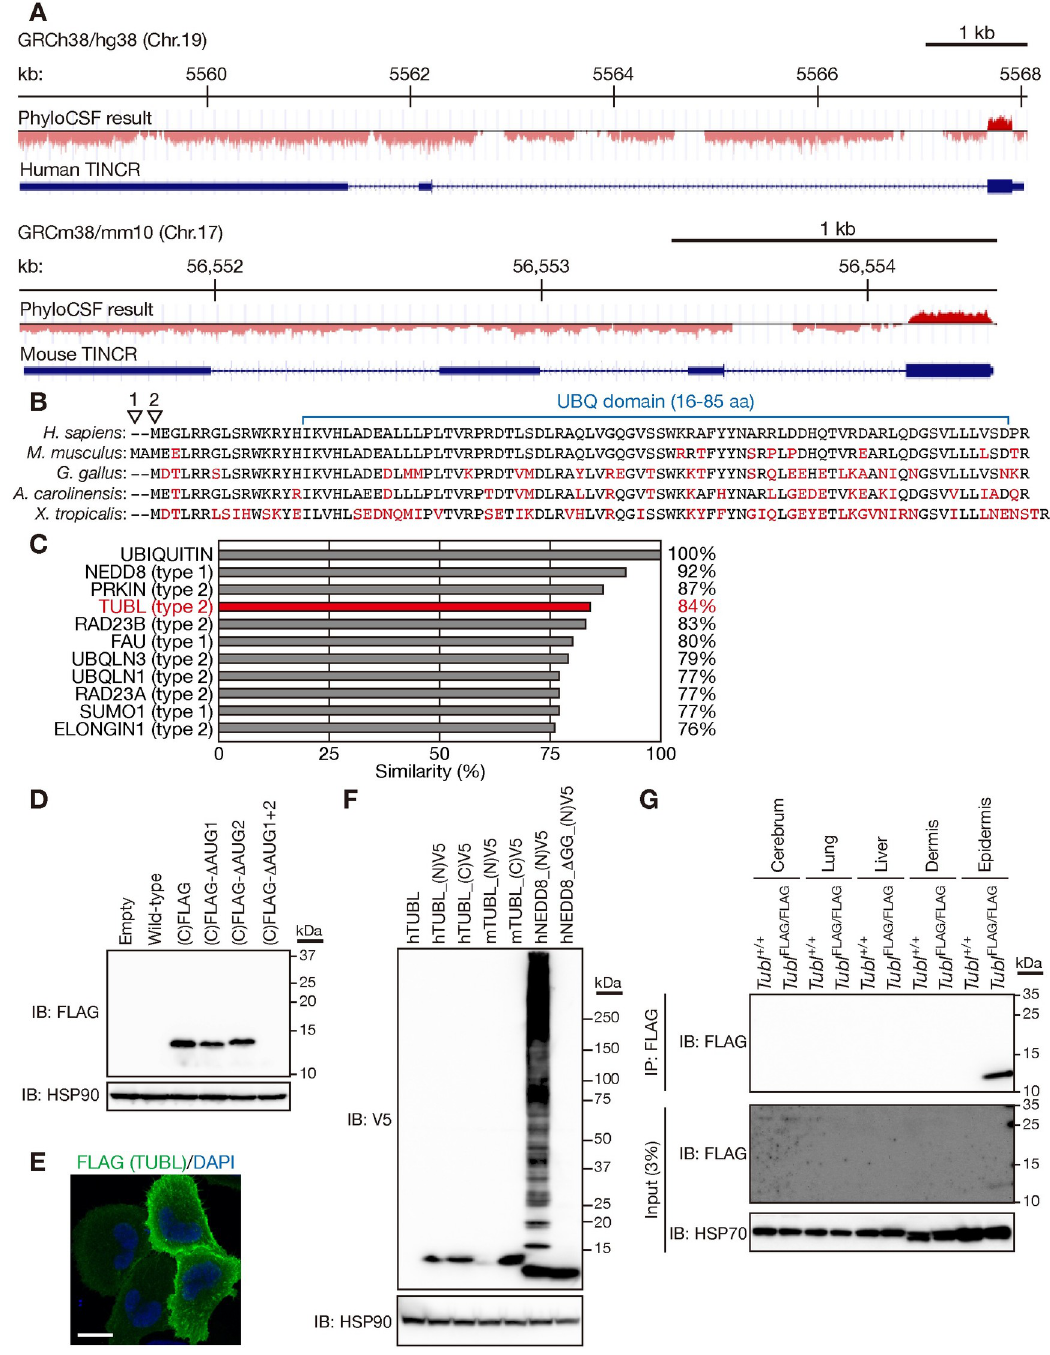
Fig 1. TINCR encodes the ubiquitin-like protein TUBL. (A) Smoothed PhyloCSF peaks for human and mouse TINCR. (B) Comparison of the predicted amino acid sequence of human TUBL with that of the mouse, avian, reptile, and amphibian proteins. Arrowheads indicate the first and second methionines of mouse TUBL. Amino acids that differ between species are shown in red. (C) Amino acid sequence similarity for human TUBL and other human ubiquitin-like proteins compared with human ubiquitin. (D) Immunoblot (IB) analysis of HEK293T cells transiently transfected with expression vectors for mouse TINCR with a FLAG epitope tag sequence inserted at the COOH-terminus (C) of the TUBL ORF or for its Δ AUG mutants. The analysis was performed with M2 antibodies to FLAG and antibodies to HSP90 (loading control). (E) Immunofluorescence analysis of FLAG in HeLa cells expressing FLAG epitope–tagged mouse TUBL. Nuclei were stained with 4 0 ,6-diamidino-2-phenylindole (DAPI). Scale bar, 20 μ m. (F) Immunoblot analysis of HEK293T cells transiently transfected with expression vectors for human (h) or mouse (m) TUBL